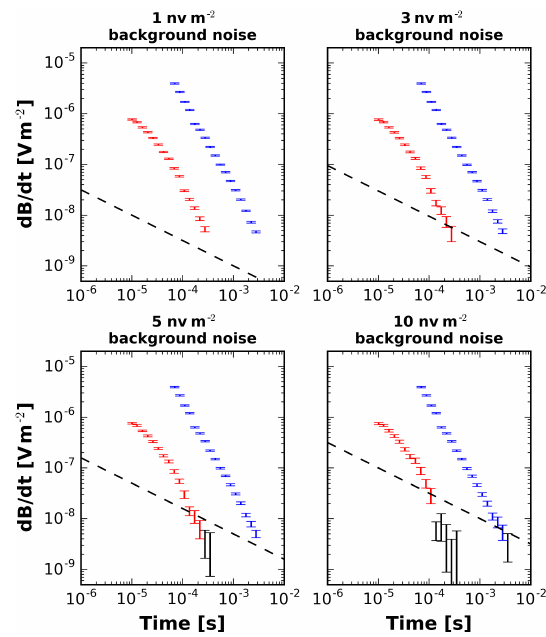
Figure 3. AEM sounding data corrupted by four levels of back- ground noise. The value on top of each subplot corresponds to the noise level at 1ms and to the b value in Eq. 6. The black dashed curves indicate the background noise levels, low and high-moment earth responses are illustrated as red and blue error bars, respec- tively, and the black error bars illustrate data which are removed by the data